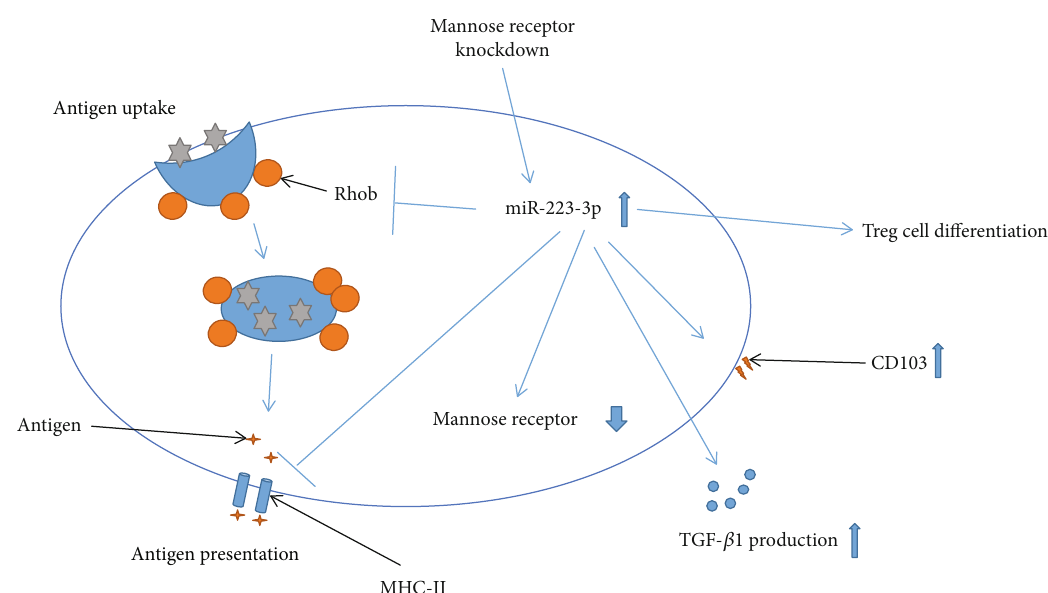
Figure 8: A schematic representation of the mechanism of miR-223-3p on regulating the antigen uptake and presentation capacities of